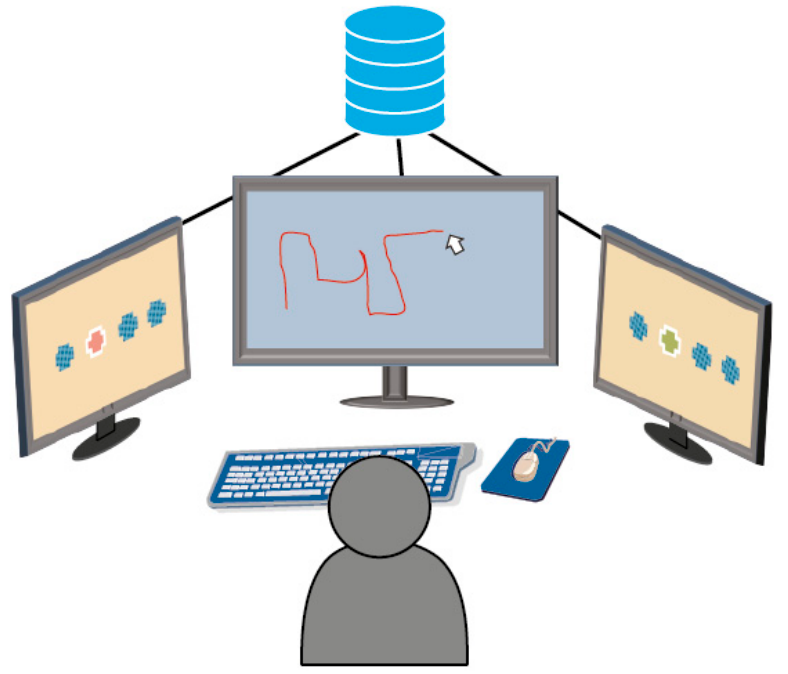
Figure 5. Multi-task mode scheme: while completing a primary task displayed on the central, mouse-operated screen (Master Pack), the participant uses keyboard to react to target stimuli presented on peripheral screens (Slave Packs).